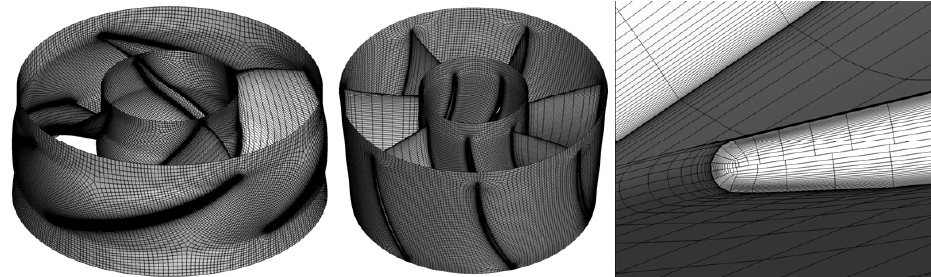
Figure 4. Impeller, guide vane and blade tip clearance grid.